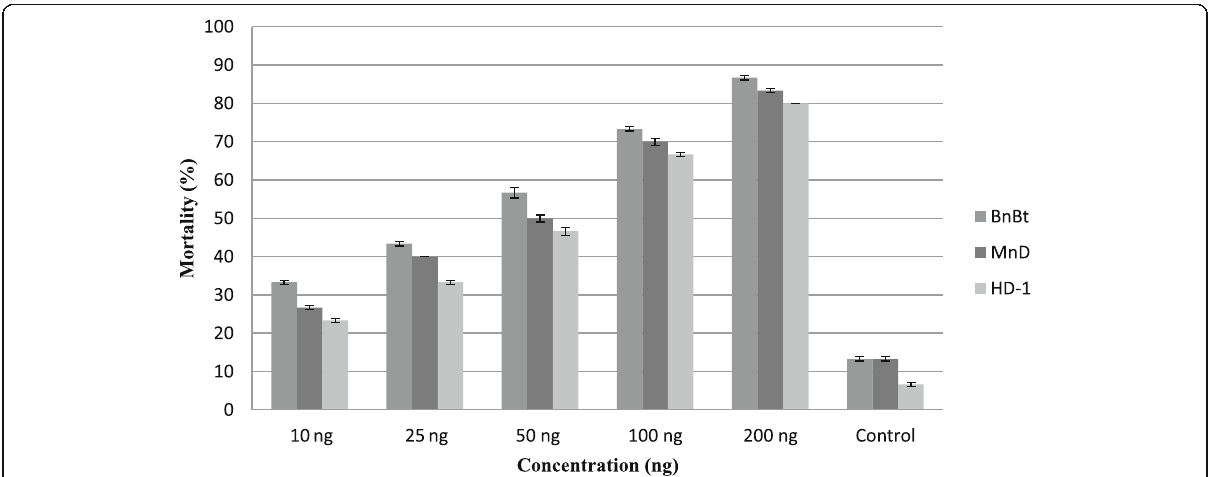
Fig. 3 Potential of Vip3 proteins of BnBt and MnD versus second instar larvae of Spodoptera